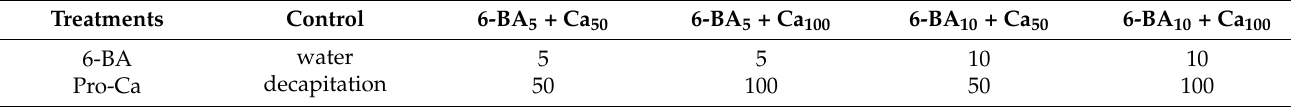
Table 1. Designs of foliar application of 6-BA combined with Pro-Ca (mg L − 1 ).